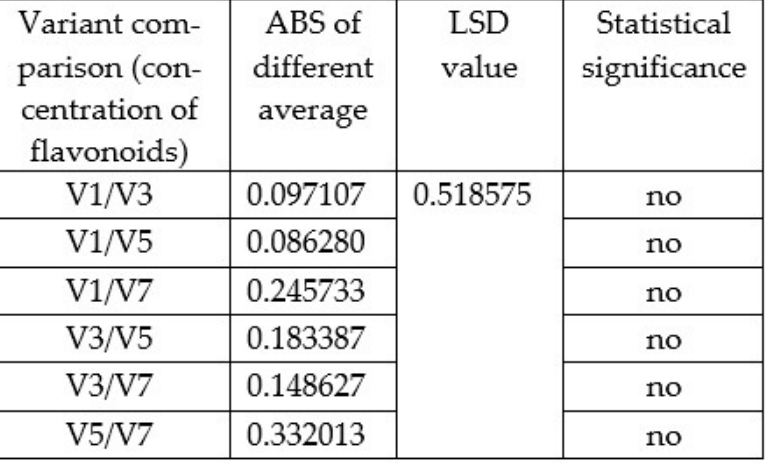
Figure 10. The statistical significance determined by LSD (Least Significant Difference) test values of flavonoid concentration in Lepidium sativum L. sprouts cultivated on gauze (V1 control, illuminated with sunlight; V3, illuminated with white LED; V5, illuminated with blue LED; and V7, illuminated with red LED experimental variant), t crit value = 2.306004.